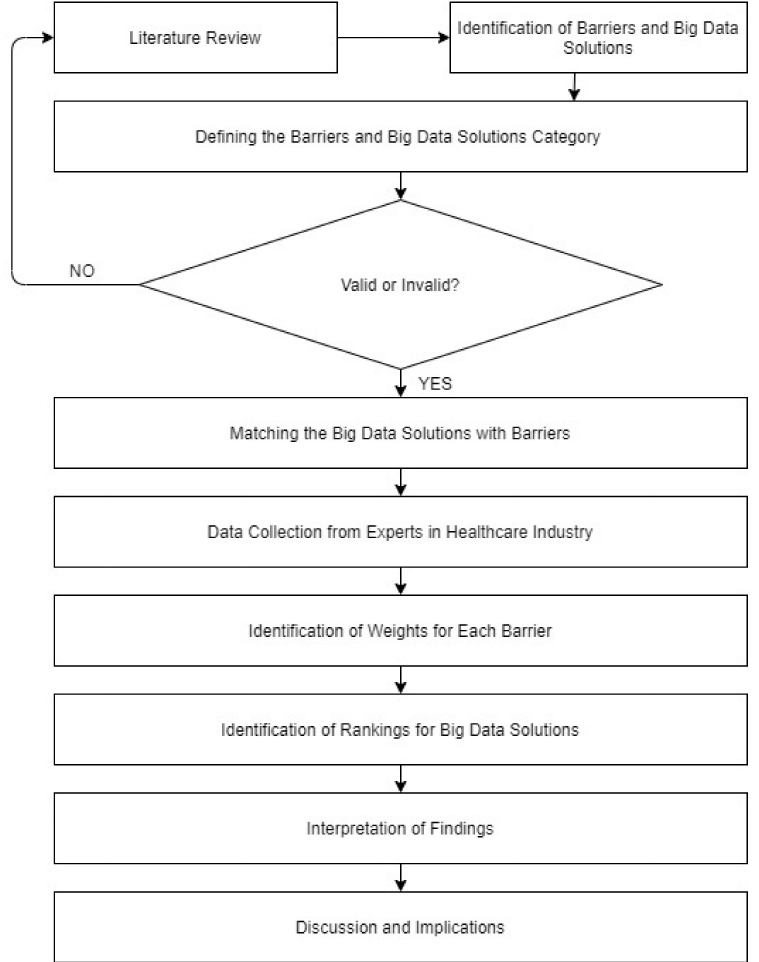
Figure 1. The overall flow of current research